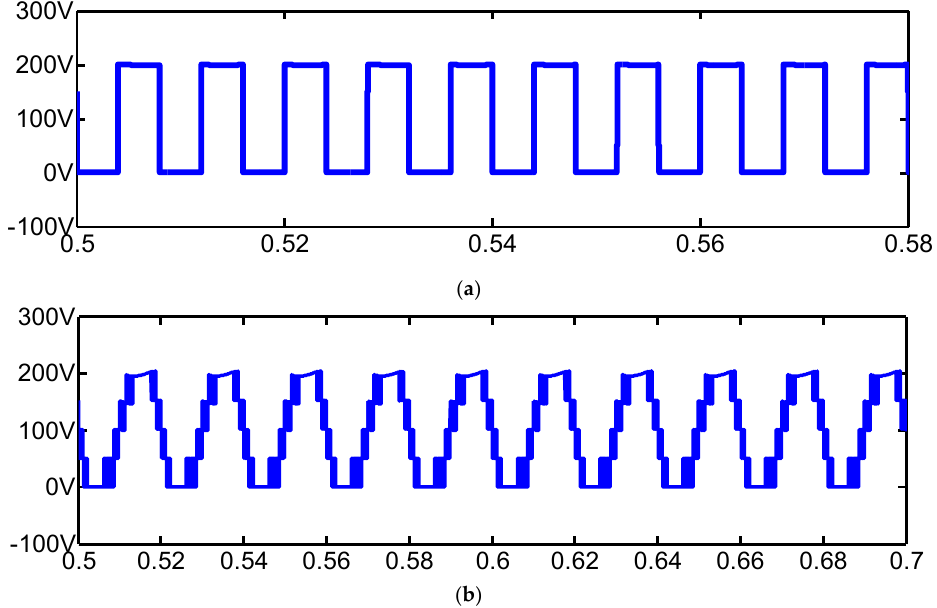
Figure 21. Upper arm voltage of the proposed hybrid MMC with different λ : ( a ) λ = 1; ( b ) λ = 0.5.